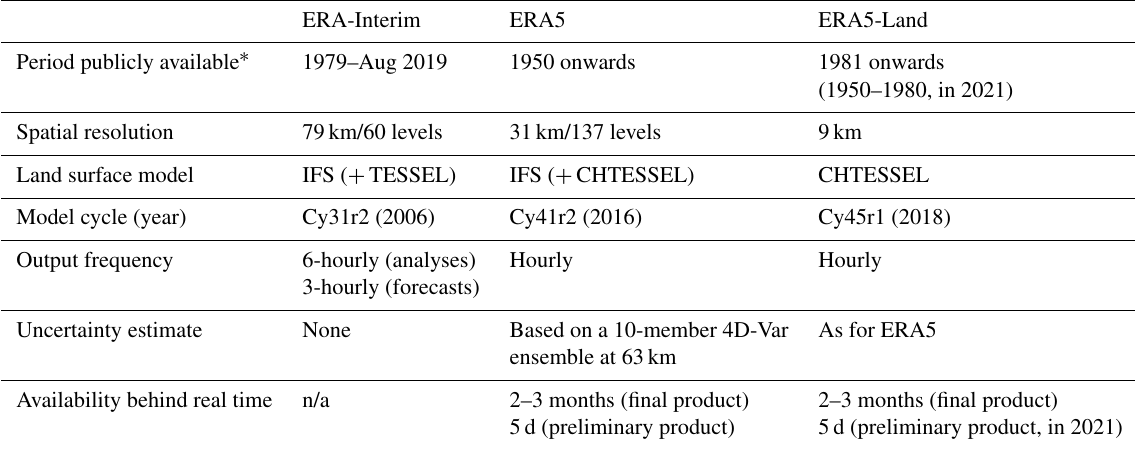
Table 1. Overview of the main characteristics of ERA-Interim, ERA5, and